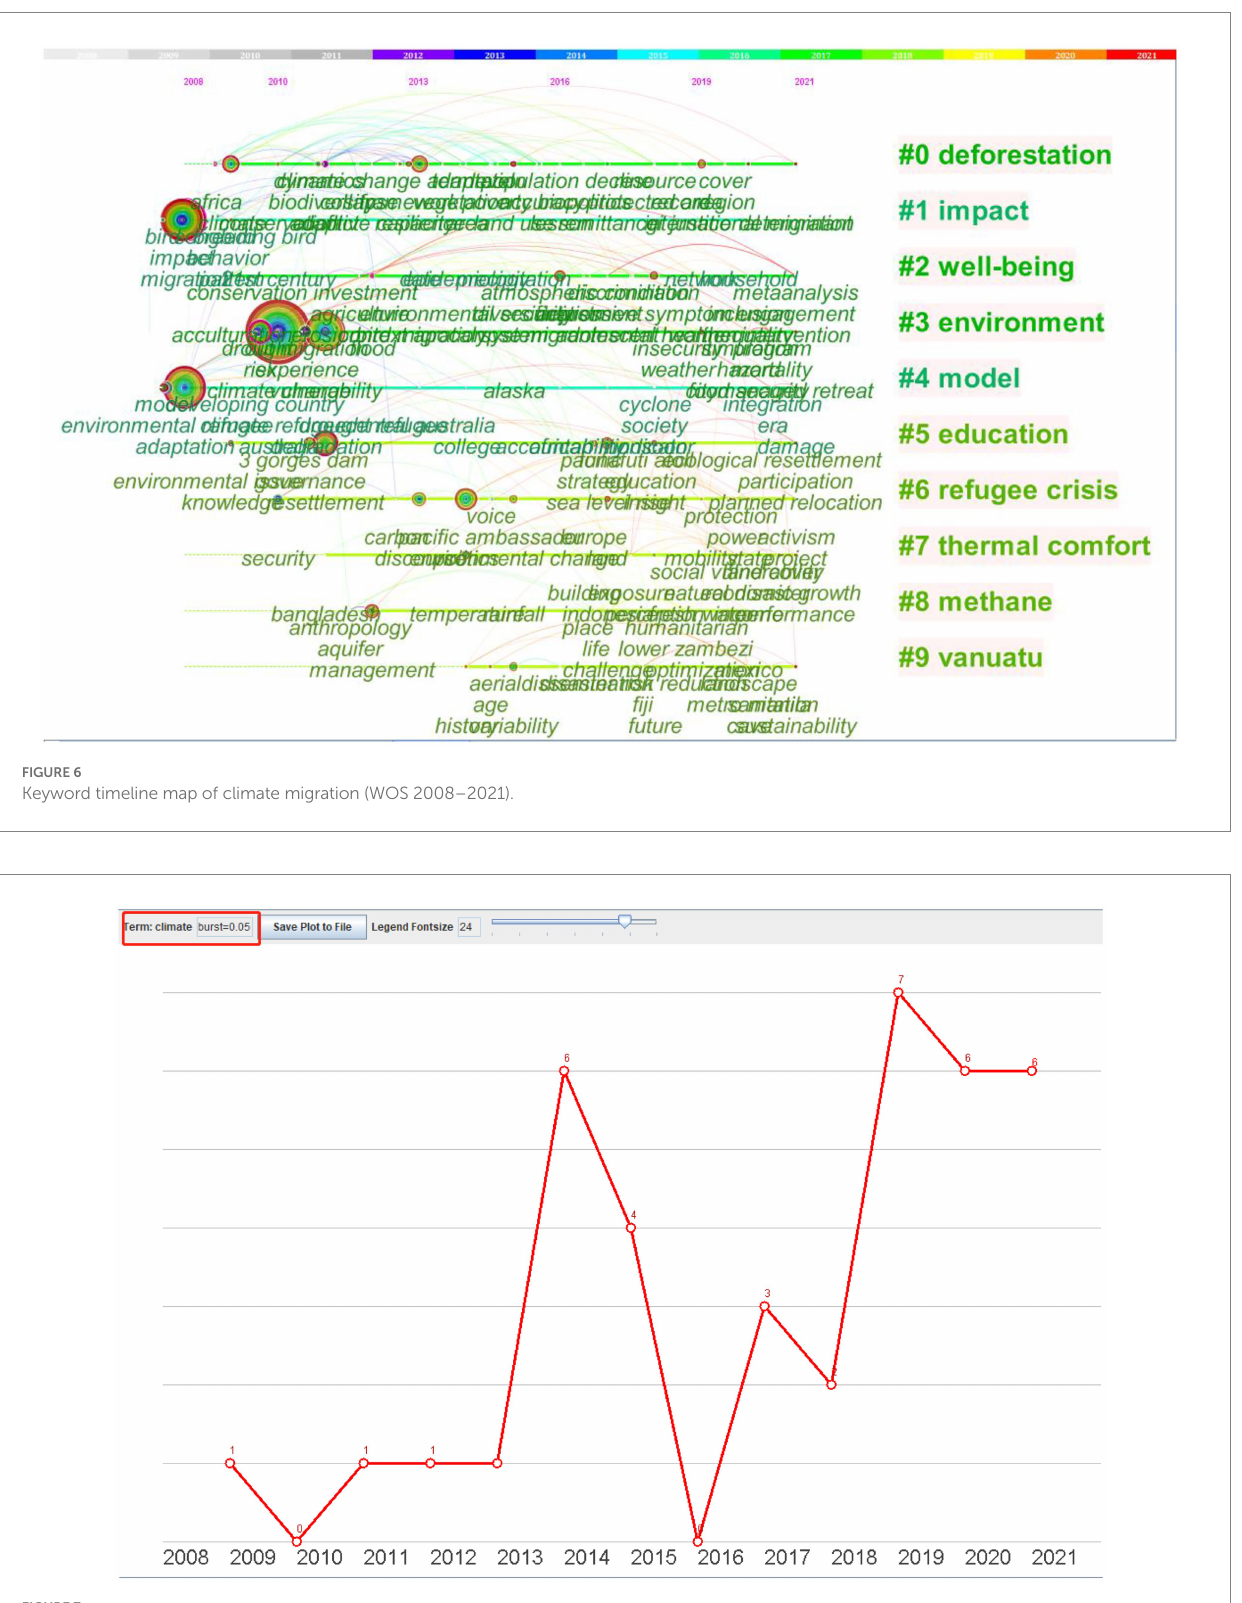
FIGURE 7 Year of the first keyword in the #0 Cluster group (WOS